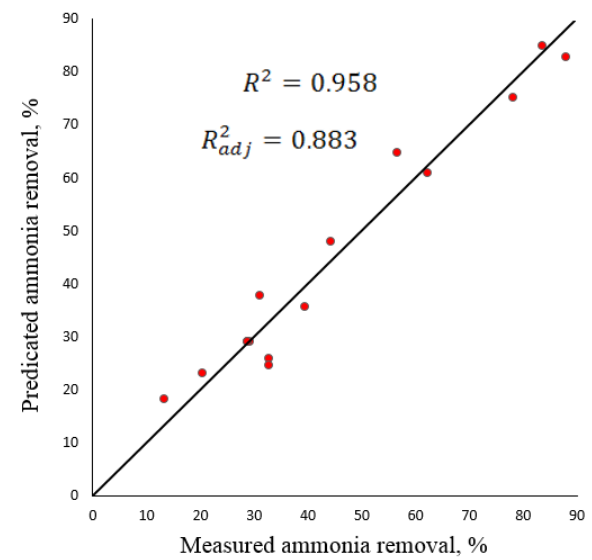
Fig. 1: Comparison of the measured and predicted values of ammonia removal Table 5: Standard deviation analysis for the quadratic model of ammonia removal